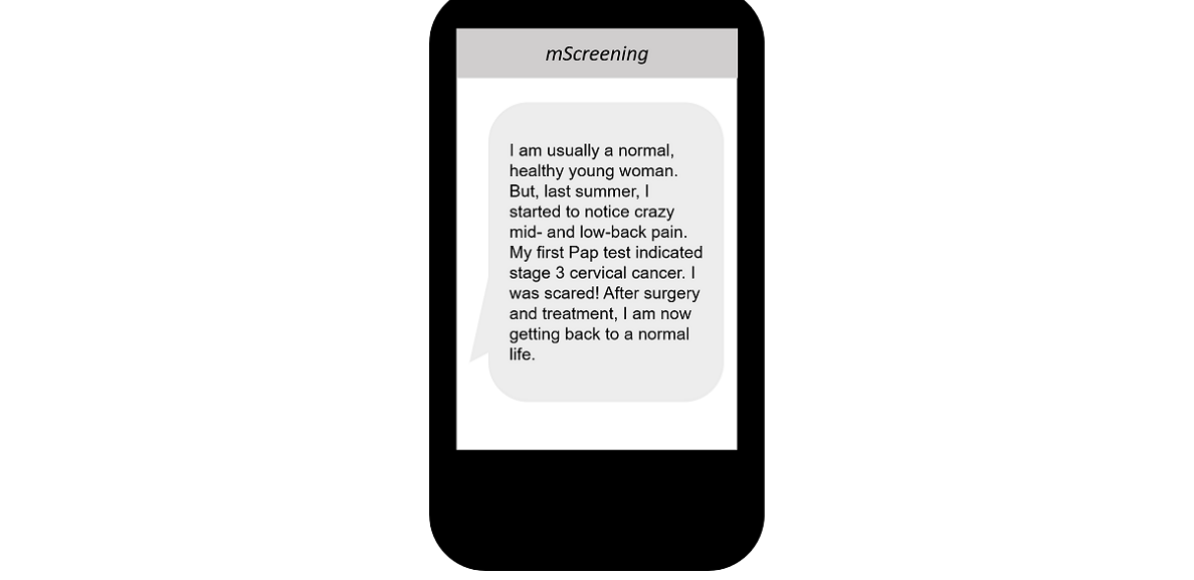
Subtheme 1.2: Culturally Targeted Message